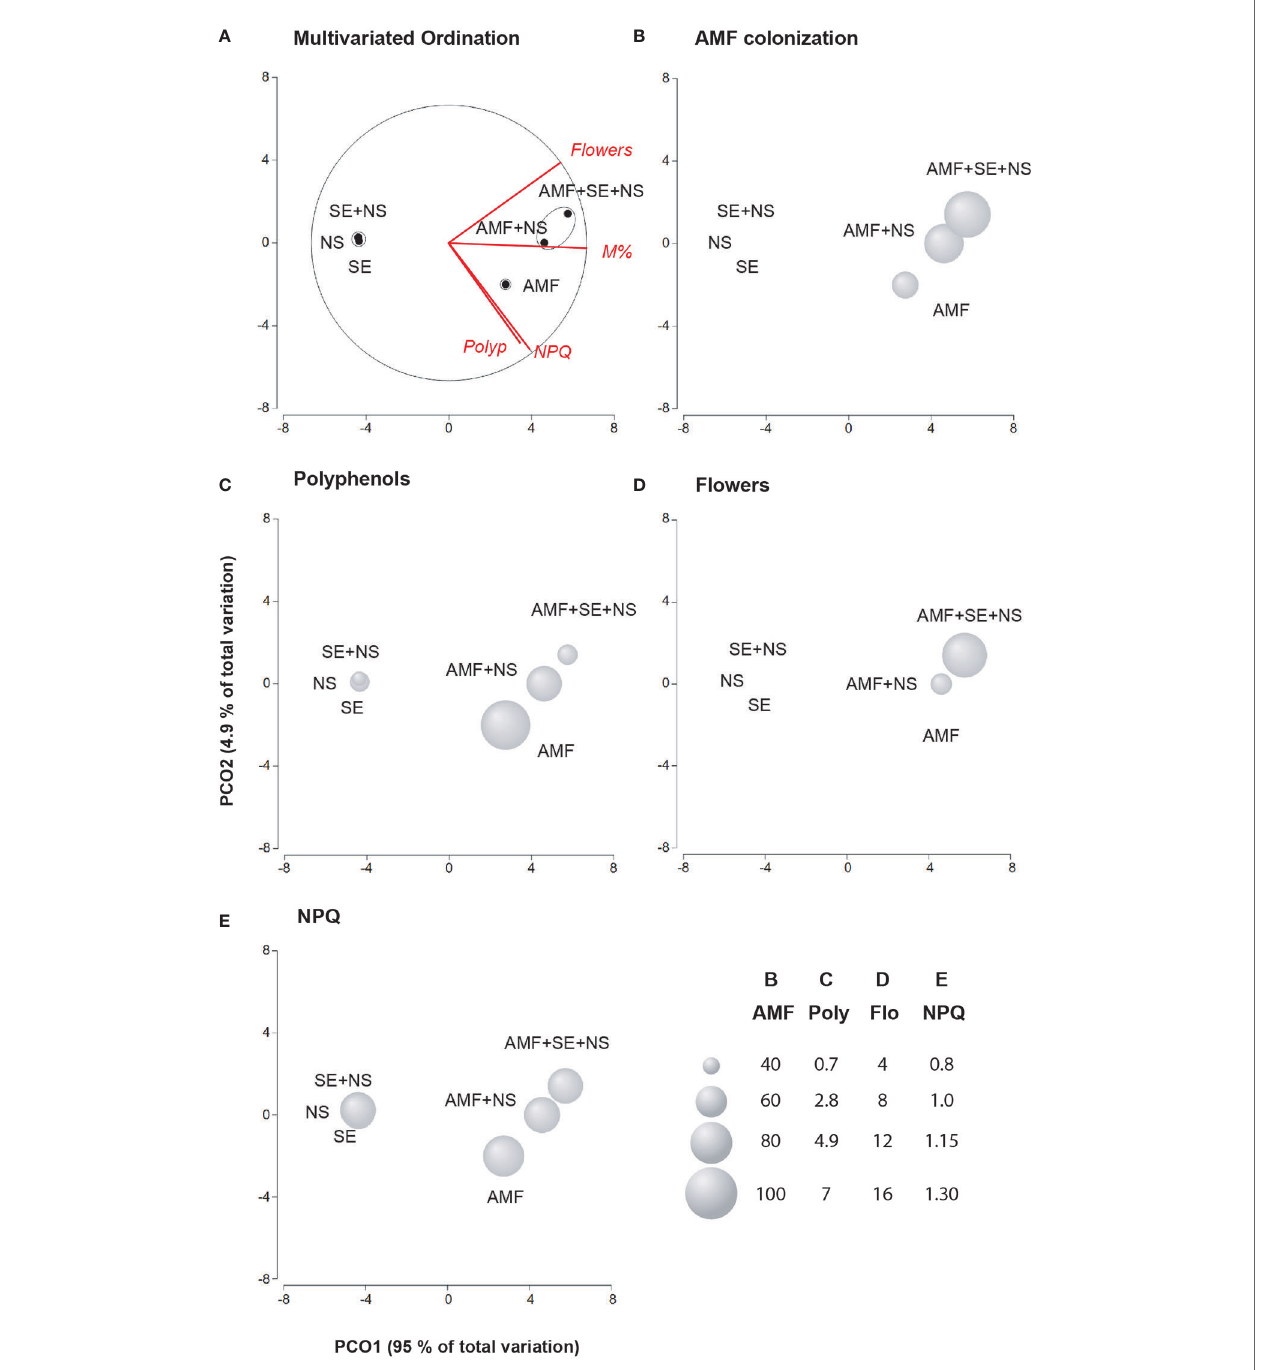
FIGURE 3 | Principal coordinates analysis (PCoA) of the ecological bene fi ts of tomato plants irrigated with nutritive solution (NS), treated with a microbial-based biostimulant containing Rhizophagus intraradices [arbuscular mycorrhizal fungi (AMF)], treated with a AMF and irrigated with the nutritive solution (AMF + NS), treated with not microbial-based biostimulant from Padina gymnospora extract [seaweed extract (SE)], treated with SE and irrigated with nutritive solution (SE + NS), and a combination of both plant biostimulants and irrigated with nutritive solution (AMF + SE + NS). (A) Multivariate ordination; (B) AMF colonization of the root system; (C) Polyphenols; (D) Flowers, (E) Nonphotochemical quenching (NPQ; n = 6